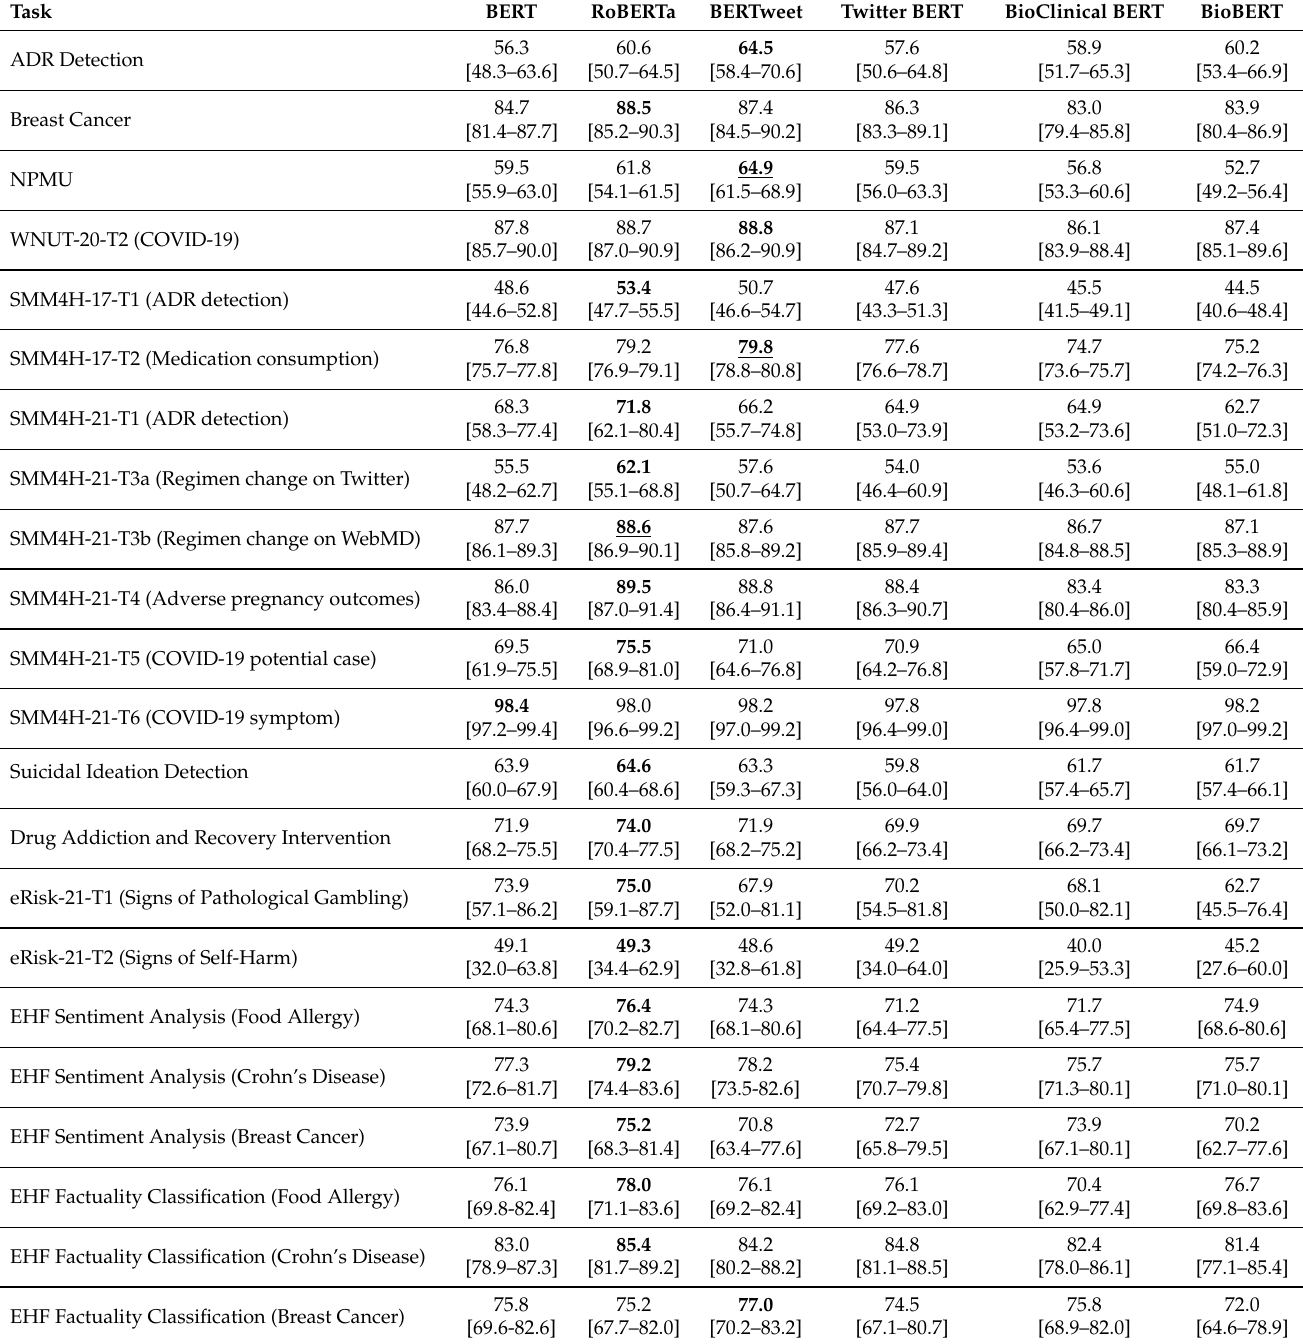
Table 2. Comparison of six pretraining strategies on 22 text classification tasks. The metric for each task is shown along with 95% confidence intervals. The best model for each task is highlighted in boldface. Models that are statistically significantly better than all other models on the same task are